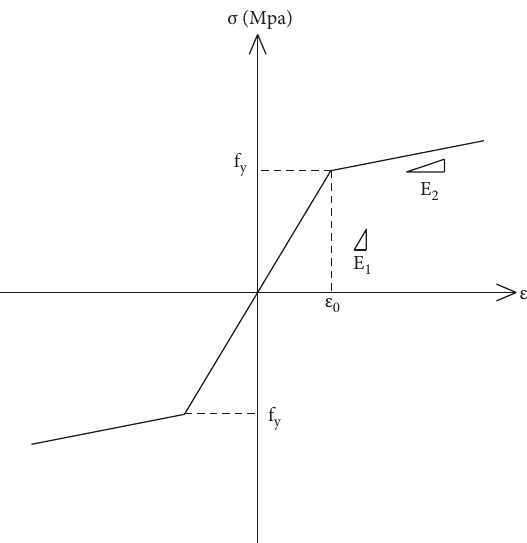
Figure 9: Constitutive relation of reinforcement.